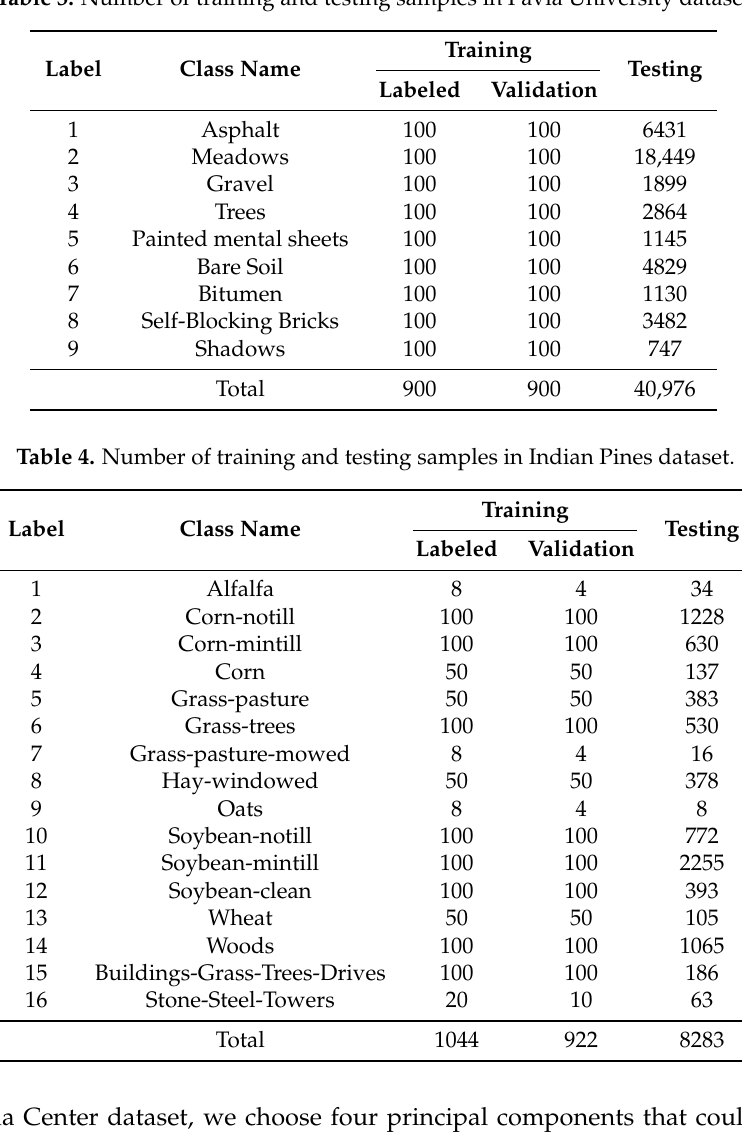
Table 3. Number of training and testing samples in Pavia University dataset.